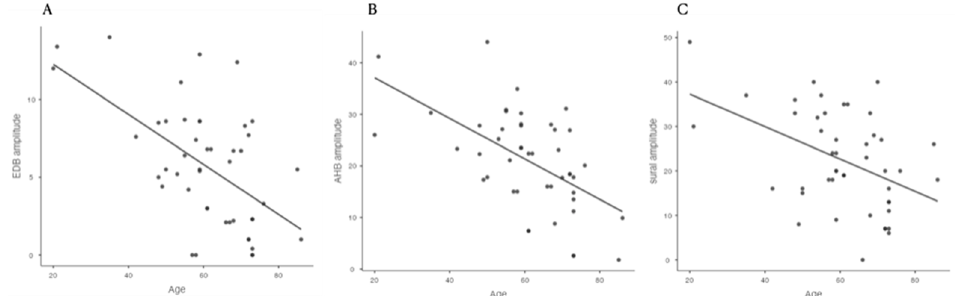
Figure 2. Age showed a statistically significant correlation with the amplitude of the EDB ( A ), AHB, ( B ) and sural nerve ( C ). EDB: extensor digitorum brevis, AHB: abductor hallucis